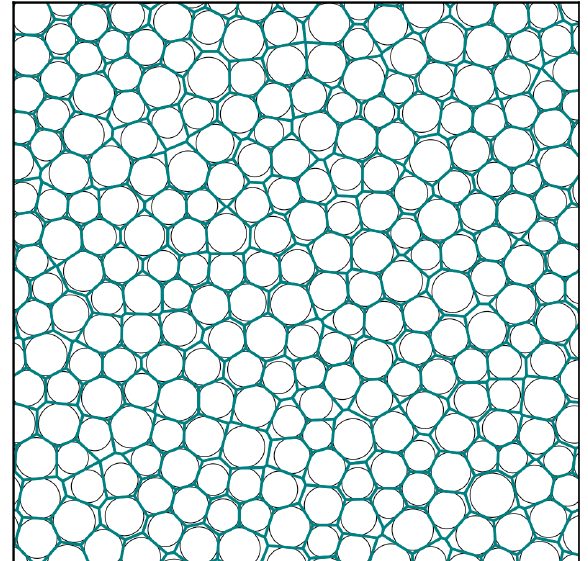
Figure 1. Example of an element distribution generated with the al- gorithm of Liang et al. (2015) showing the circular elements (grey) and the radical Voronoi tessellation